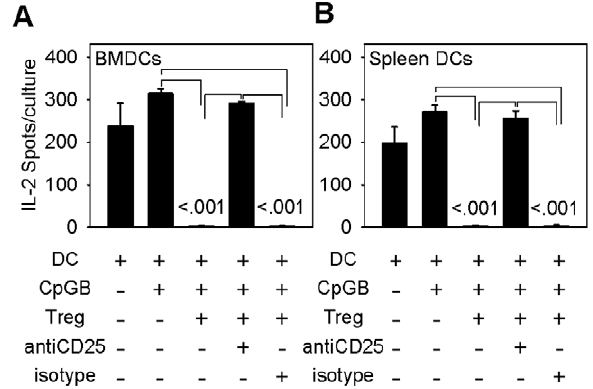
Figure 5. Tregs interfere with dendritic cell paracrine secretion of IL-2. Treg interference of dendritic cell paracrine secretion of IL-2 depends on CD25. C57BL/6 splenic DCs (left) and BMDCs (right) were cultured in IL-2 ELISPOT plates unstimulated or with CpG-B, with and without DO11.10 Treg cells, anti-CD25, or isotype control, and the number of IL-2 secreting DCs was measured as in materials and methods. Bars are the mean 6 SE of IL-2 secreting DCs in triplicate samples of one of six representative experiments with splenic DCs (left) and one of three representative experiments with BMDCs (right). Statistical analysis by one-way repeated measures ANOVA and Tukey’s test for all pairwise multiple comparison procedure.